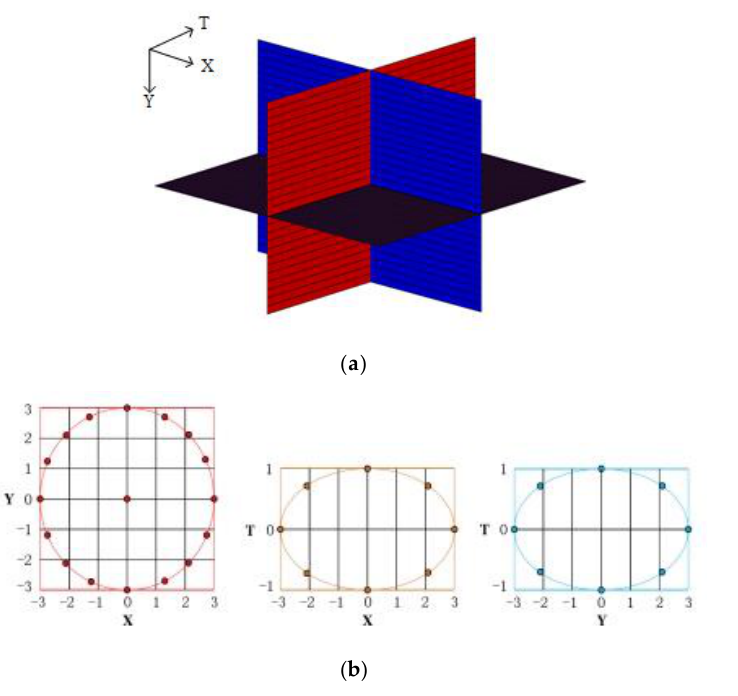
Figure 5. ( a ) Schematic diagram of three orthogonal planes; ( b ) Each plane extends the neighborhood. Figure 6 shows the schematic diagram of extracting image sequences in three orthogo- nal planes.